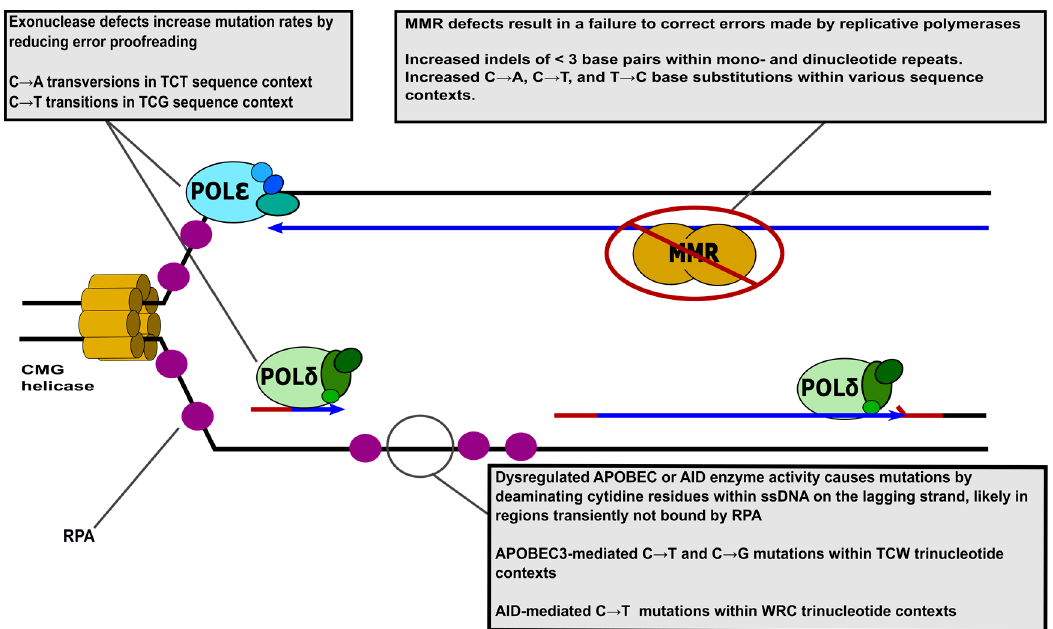
Figure 1. Replication fork structure and mutagenic changes in enzyme activity. Replicative DNA polymerases Pol δ (green) and Pol ε (blue) are shown on the lagging and leading strands, respectively. ssDNA binding protein RPA is depicted as purple circles. The template DNA stands, RNA primers, and newly synthesized daughter stands are represented by black, red, and blue lines, respectively. Please note that simplified depictions of proteins do not convey structural information and are not to scale. The grey call-out boxes describe mutagenic activities at the replication fork and associated mutation signatures from human tumors. Several important proteins present at the replication fork, the Replication factor C (RFC) complex, proliferating cell nuclear antigen (PCNA), and Pol α have been omitted for the sake of simplicity. W (either A or T), R (either A or G).